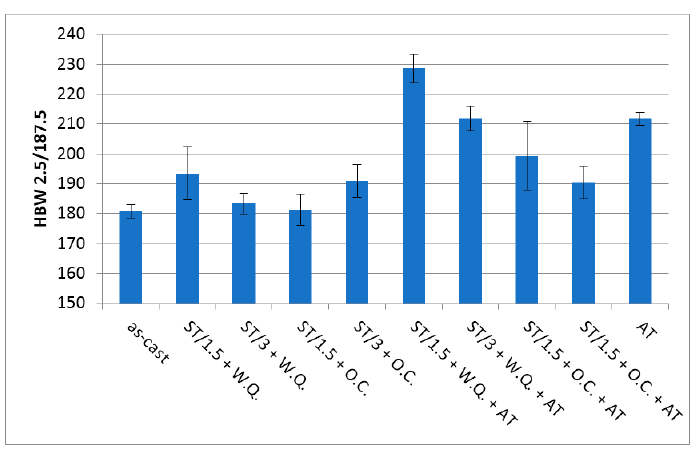
Figure 8. Macro-hardness obtained for different heat treatments.